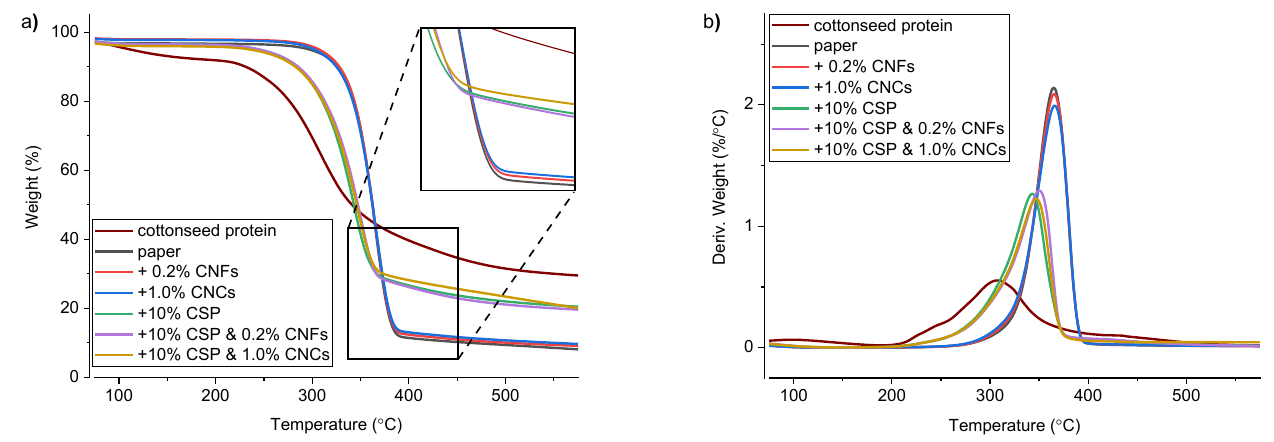
Figure 2. ( a ) TGA and ( b ) DTG data for CSP (brown), paper (black), paper + CNFs (red), paper + CNCs (blue), paper + CSP (green), paper + CSP + CNF (violet), and paper + CSP + CNC (gold); DTG, derivative thermogravimetry; TGA, thermogravimetric analysis. Table 2. Thermal properties of cottonseed protein isolate and paper samples treated with cottonseed protein and nanocellulose